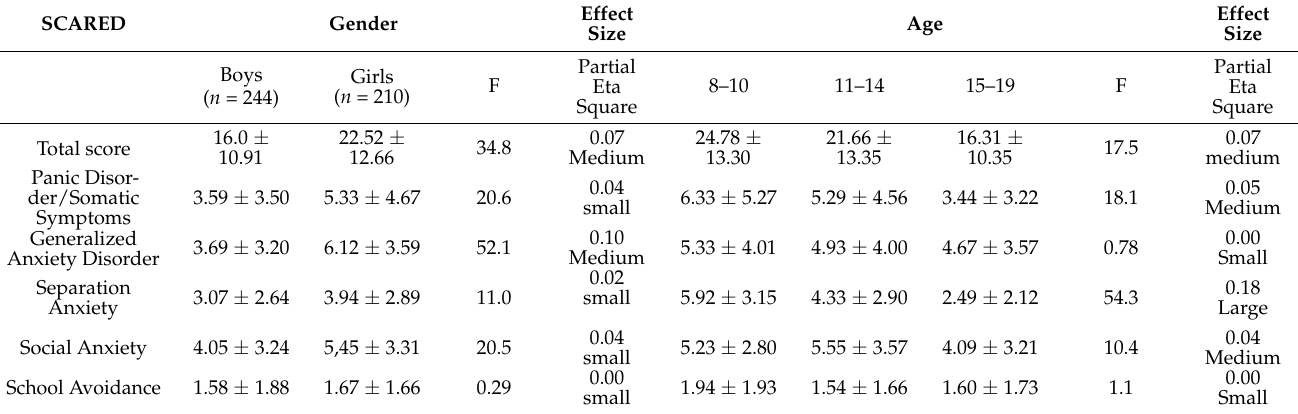
Table 5. Gender and age differences and effect size (MANOVA